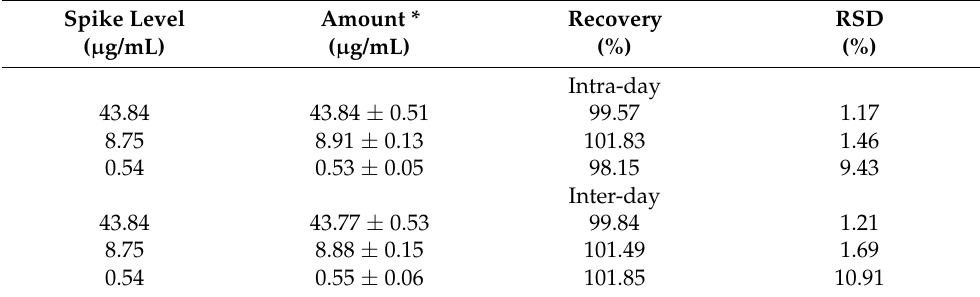
Table 4. Accuracy and precision of 2 S -LP2 determination by HPLC. RSD = relative standard deviation. * n =